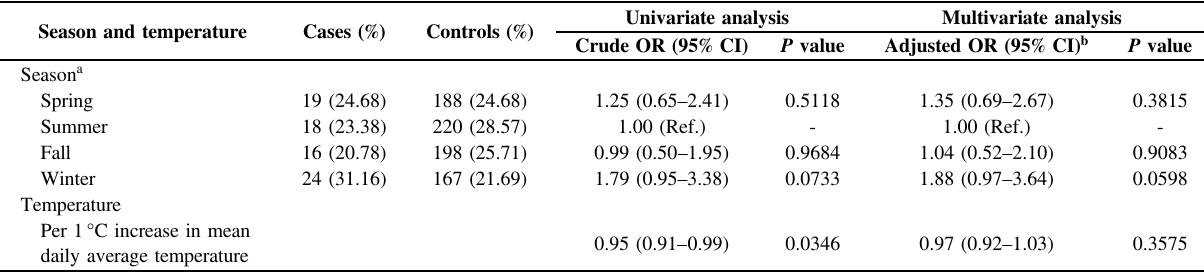
Table 2 Associations of hyperglycemic emergency incidence with season and